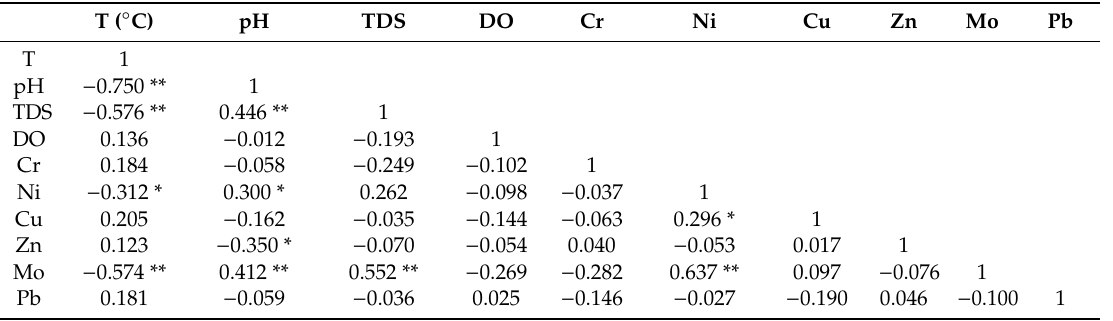
Table 3. Pearson correlation matrix of water parameters and dissolved heavy metals in the Lancangjiang River.